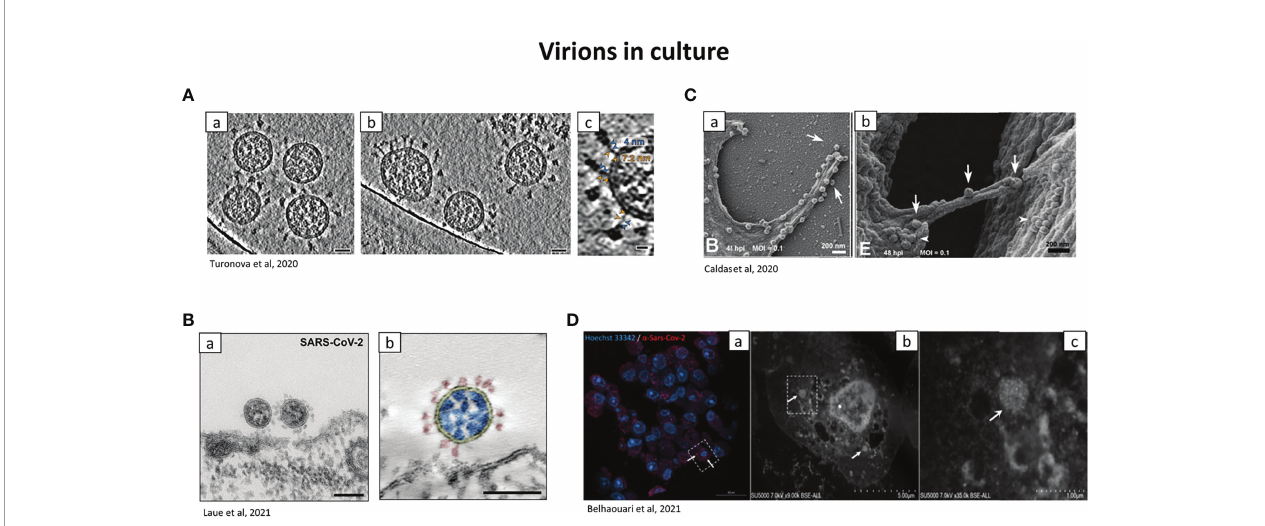
FIGURE 5 | Representative electron micrographs showing the localization of SARS-CoV-2 virions in tissue culture. (A) Cryo – electron tomography of SARS-CoV-2 virions. a.b SARS-CoV-2 virions isolated from culture and centrifugated, observed by cryo-electron tomography. Scale bar: 30nm. c: zoom on the hinge of SARS- CoV-2, with the spike proteins. Blue and orange arrowheads: upper and lower legs, with their length indicated. Scale bar: 10 nm. (Turonova et al., 2020). (B) SARS- CoV-2 observed with Transmission EM. (a) TEM of Vero cells infected with SARS-CoV-2 (ultra-thin sections). Picture of viruses attaching to the surface of the cell. Scale bar: 100nm. (b) Transmission EM of a SARS-CoV-2 virus particle of at the surface of a Vero cell in an ultrathin plastic section (10 summed up digital slices of an electron tomogram). The colours were added manually: yellow=virus enveloping membrane, red=surface projection (spike, peplomer; trimeric S protein), blue=ribonucleoprotein (N protein and RNA). Scale bar=100 nm (Laue et al., 2021). (C) Virions at the surface of Vero cells by SEM. (a) Adherence of SARS-CoV-2 on phyllopodium-like extensions. (b) arrows indicate viral particles on a bridge between 2 infected cells. Arrowheads: aggregates of SARS-CoV-2 particles can be observed at the surface of both cells (Caldas et al., 2020). (D) Correlative light and electron microscopy of SARS-CoV-2 infected Vero E6 cells. a: confocal microscopy of a 100 nm-thick ultra-thin section (Z maximal projection). Blue: Hoechst 33342, nuclei; red: SARS-CoV-2 spike proteins. b,c: SEM of the ultra-thin section shown in (A) Higher magni fi cation of the box shown in (a) Boxed region in b is shown in (c) arrows: clusters of SARS-CoV-2-like particles. Scale bars: a: 20 µm b: 5 µm c: 1 µm (Brahim Belhaouari et al.,